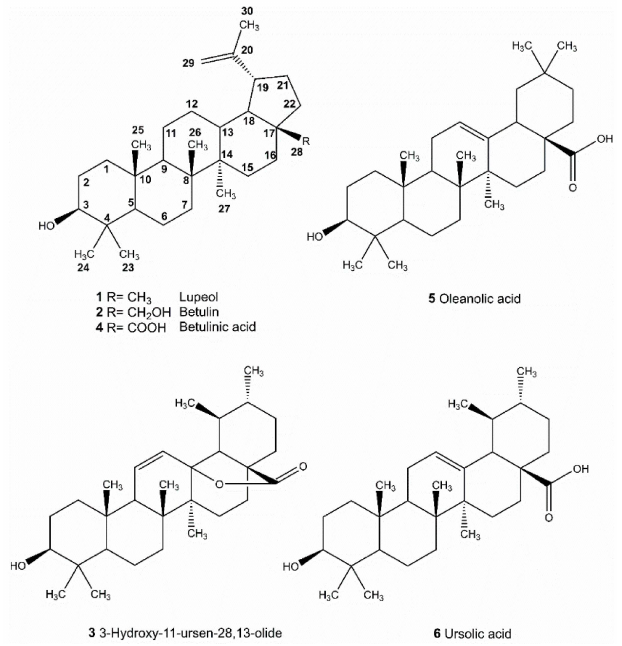
Figure 1. Pentacyclic triterpenoids isolated and identified from A. scholaris